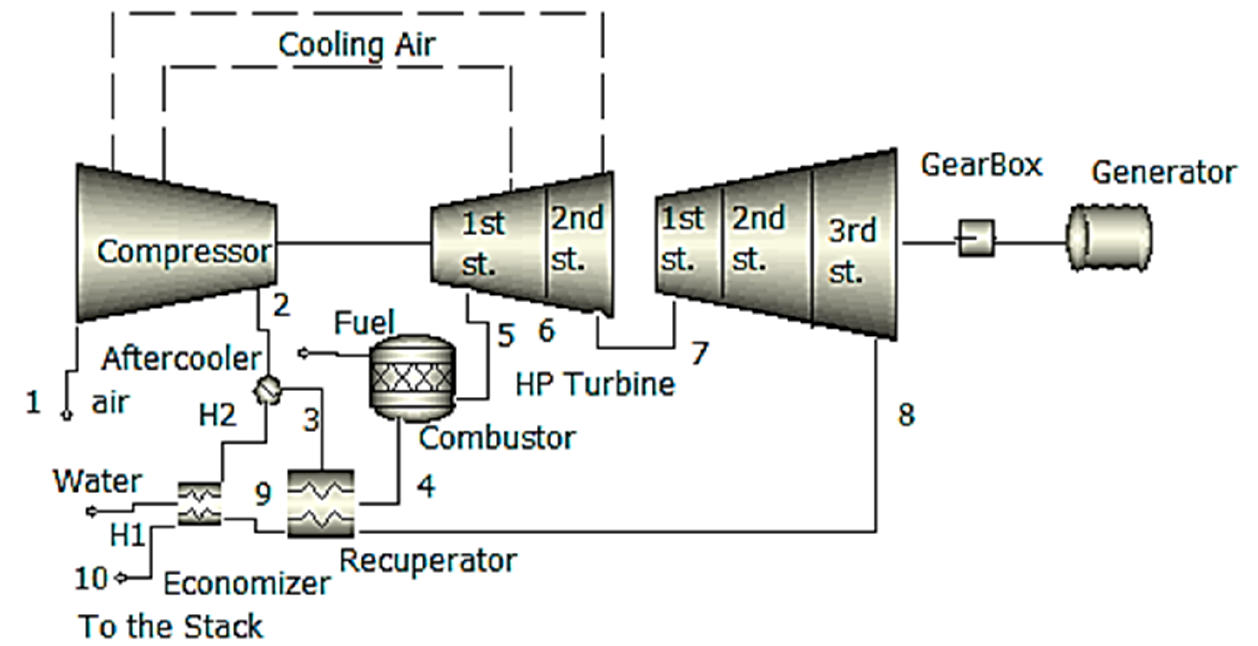
Figure 4. Schematic of the RWI cycle industrial gas turbine.